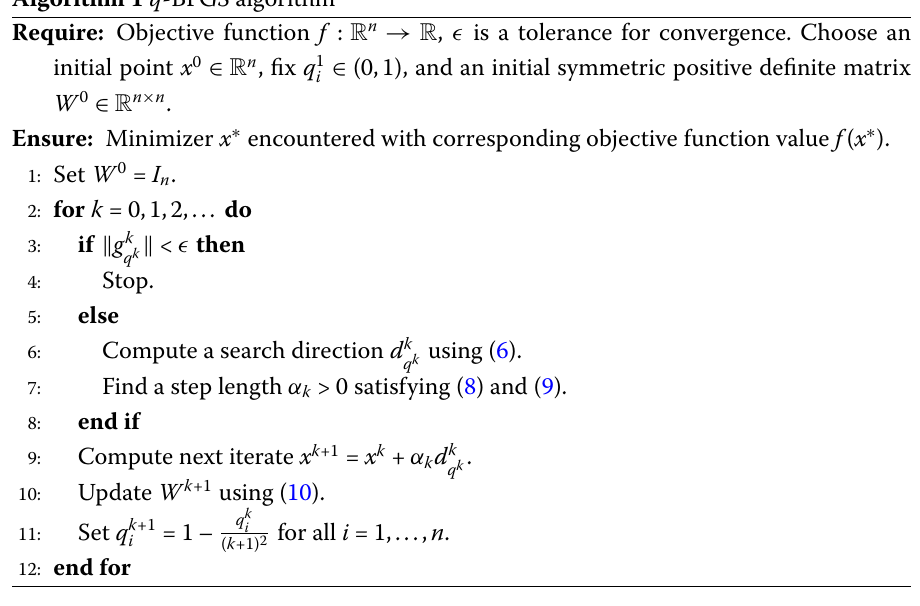
Algorithm 1 q -BFGS